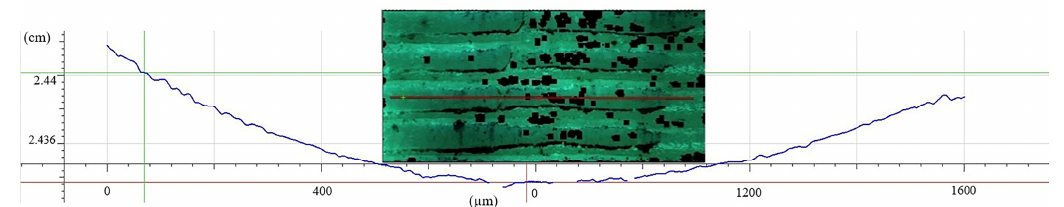
Figure 9. Image of a section of the worn area and variation recorded when wear occurred on the Extrudr BDP Flax material.